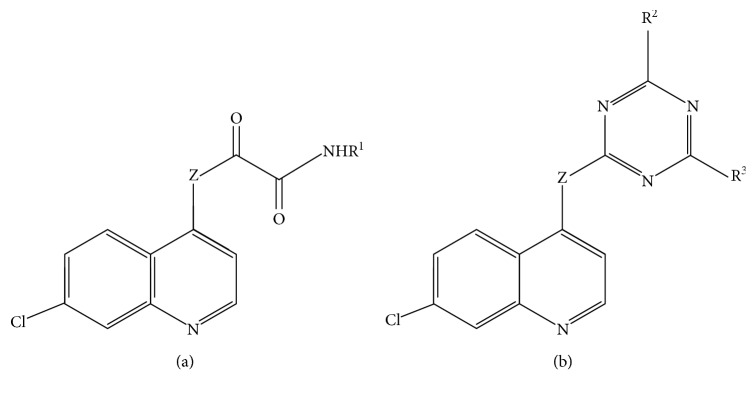
The general structure of 4-aminoquinoline-oxalamides (a) and 4-aminoquinoline-triazines (b).